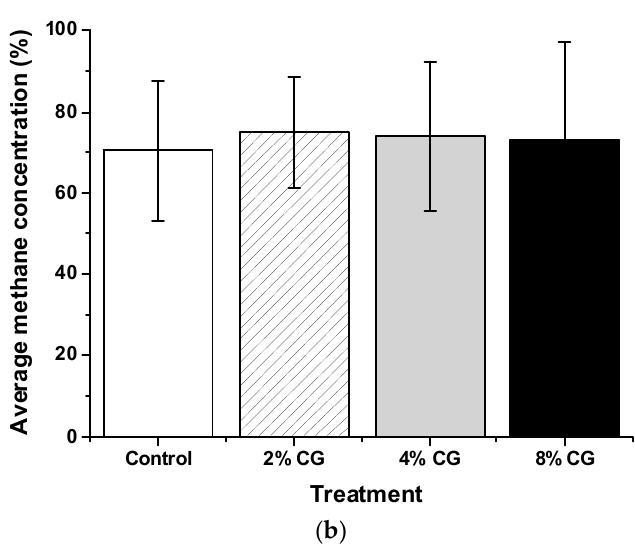
Figure 3. Effects of adding different percentage of crude glycerol on ( a ) daily methane concentration and ( b ) average methane concentration.